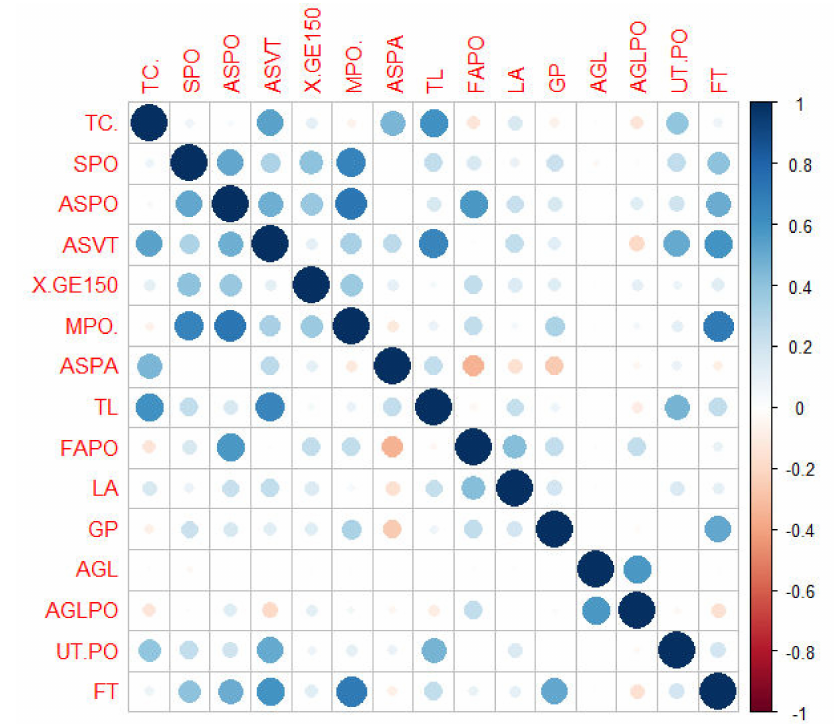
Figure 1. Heatmap of the correlation matrix (fifteen